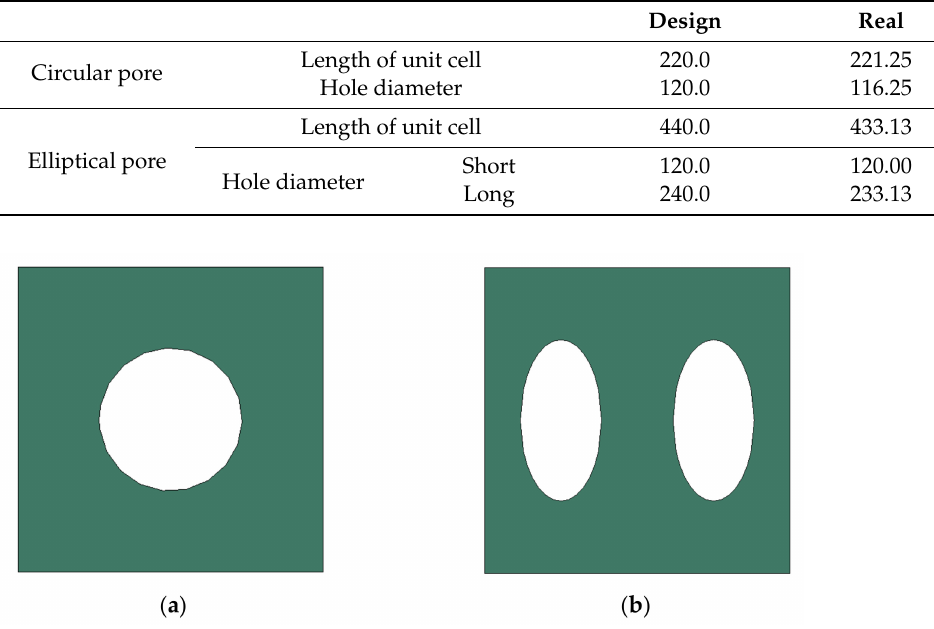
Figure 7. ( a ) Shape of optical microscope. ( b ) Image with optical microscope. Table 1. Comparison of design proposal and actual results (unit: µ m).